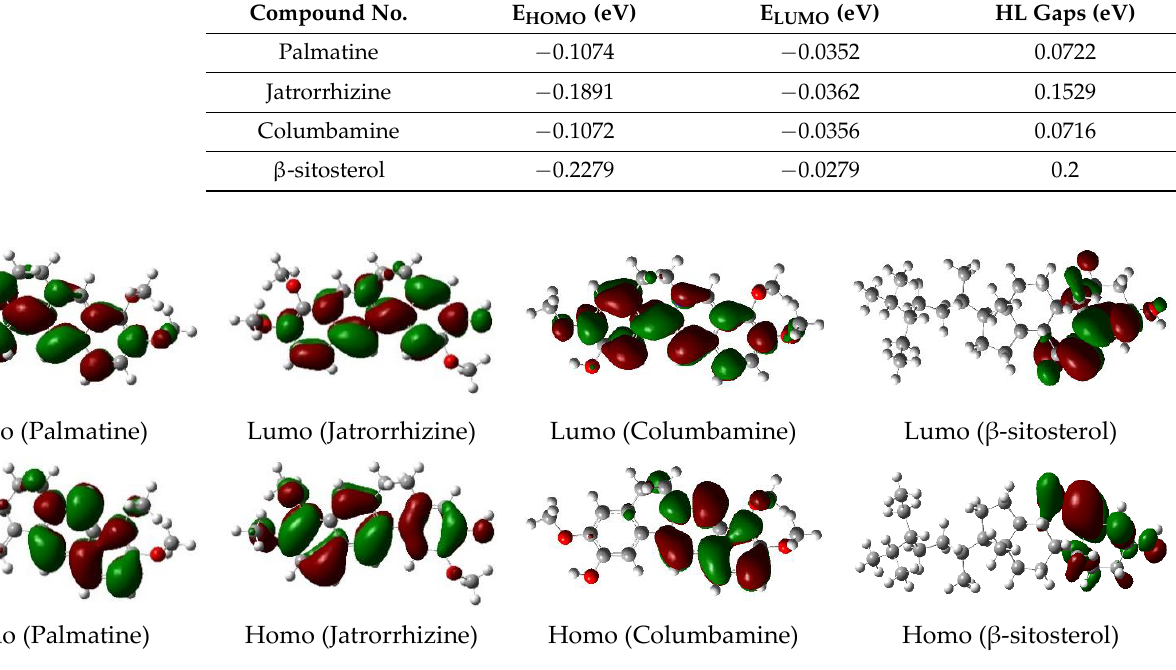
Figure 9. LUMO and HOMO maps for isolated compounds from DFT calculations. The green parts represent positive molecular orbitals, and the red parts represent negative molecular orbitals. Table 5. LUMO and HOMO energies and HOMO – LUMO (HL) gaps (in eV) of isolated compounds. Compound No.